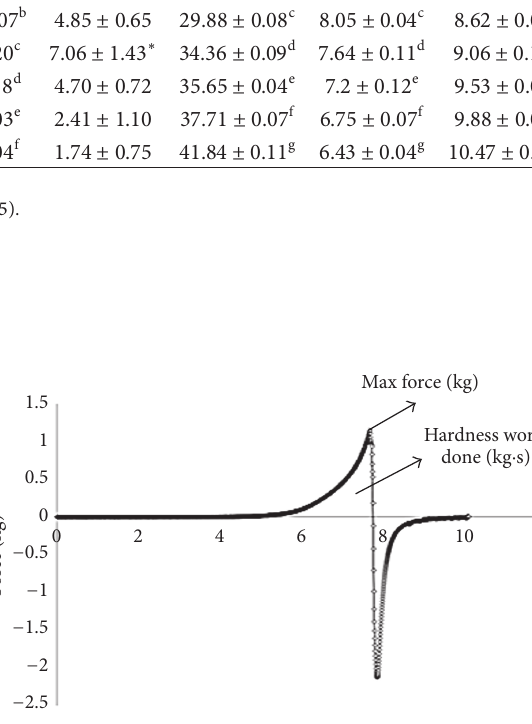
Figure 1: Typical texture profile analysis curve of carob